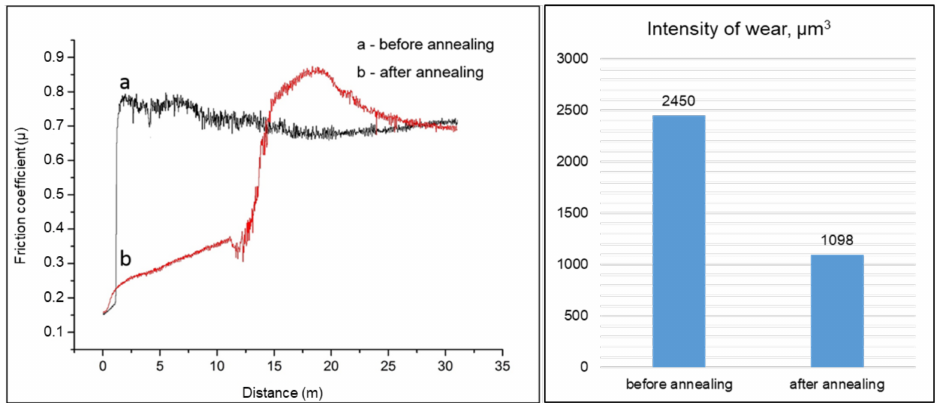
Figure 12. Results of tribological experiments of Ti–Si–C coatings before and after annealing at 800 ◦